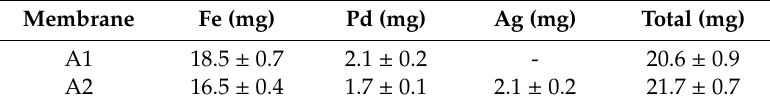
Table 2. Amount of metal embedded in the nanocomposite membranes.